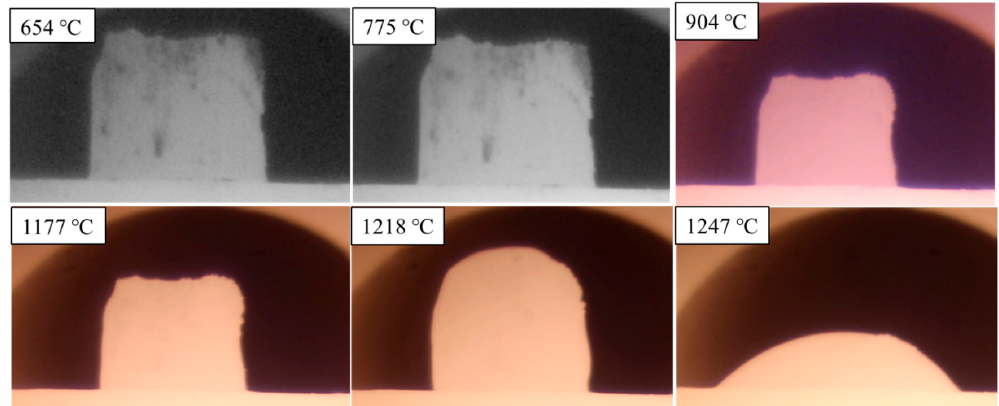
Figure 2. Typical sequence of images of the 4% TiO 2 glass sample obtained with the heating microscope digital camera.